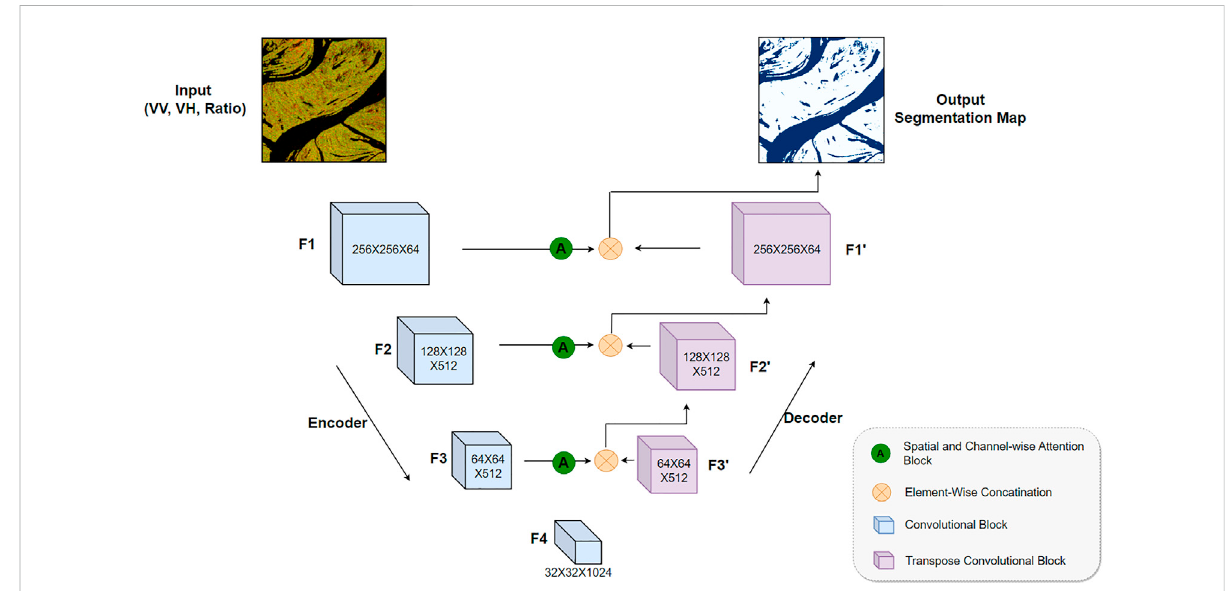
FIGURE 3 Architecture of Attentive U-Net. The network takes 3-channel (VV, VH, VV/VH) input and generate a binary segmentation map as output.